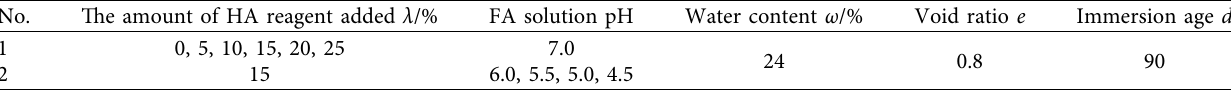
Table 4: Microstructure test conditions.